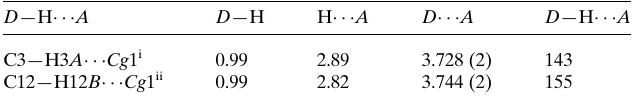
Table 1 Hydrogen-bond geometry (A˚ , (cid:7) ). Cg 1 is the centroid of the C5–C10 ring.